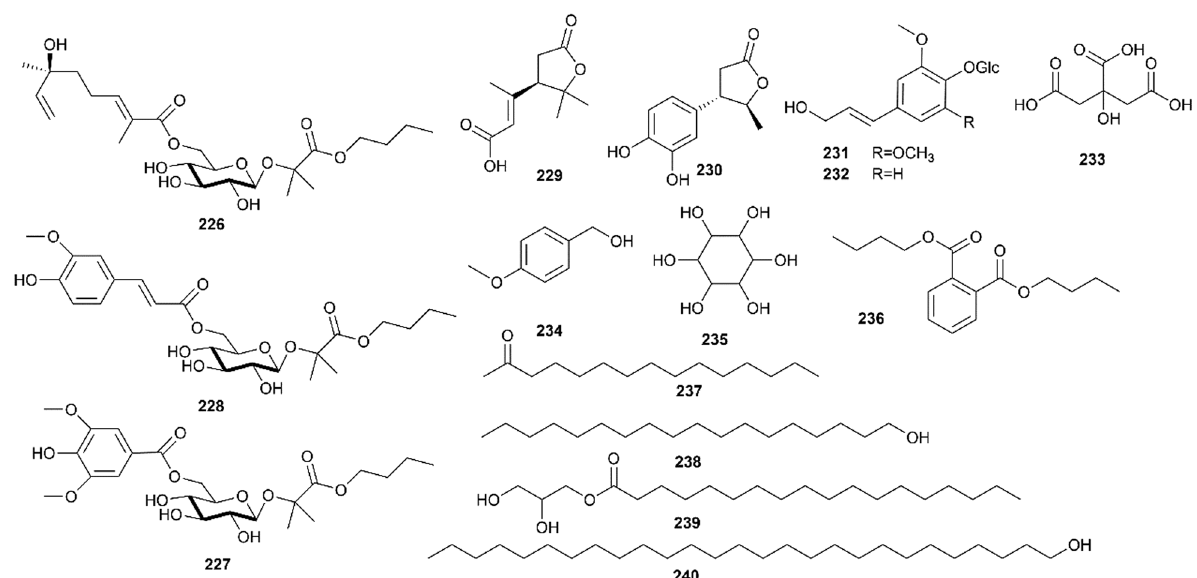
Fig.10 Other compounds isolated from Euodiae